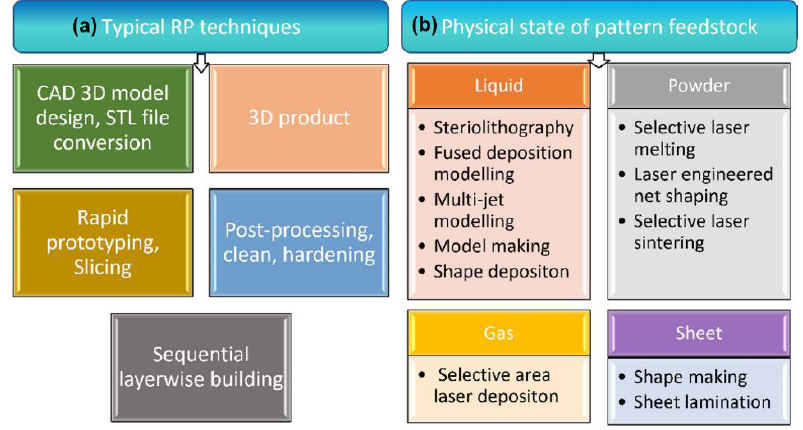
Figure 14. ( a ) Typical RP process flow [150]. ( b ) Classification of RP techniques based on physical state of feedstock [182].